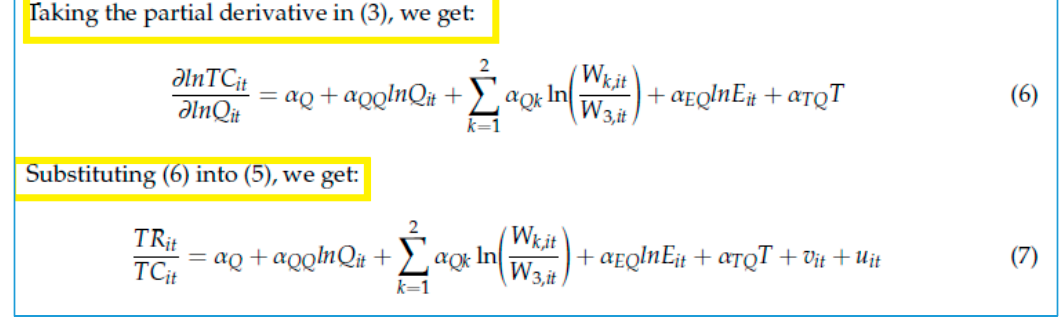
Figure 1. A part of the Lerner index calculation process.